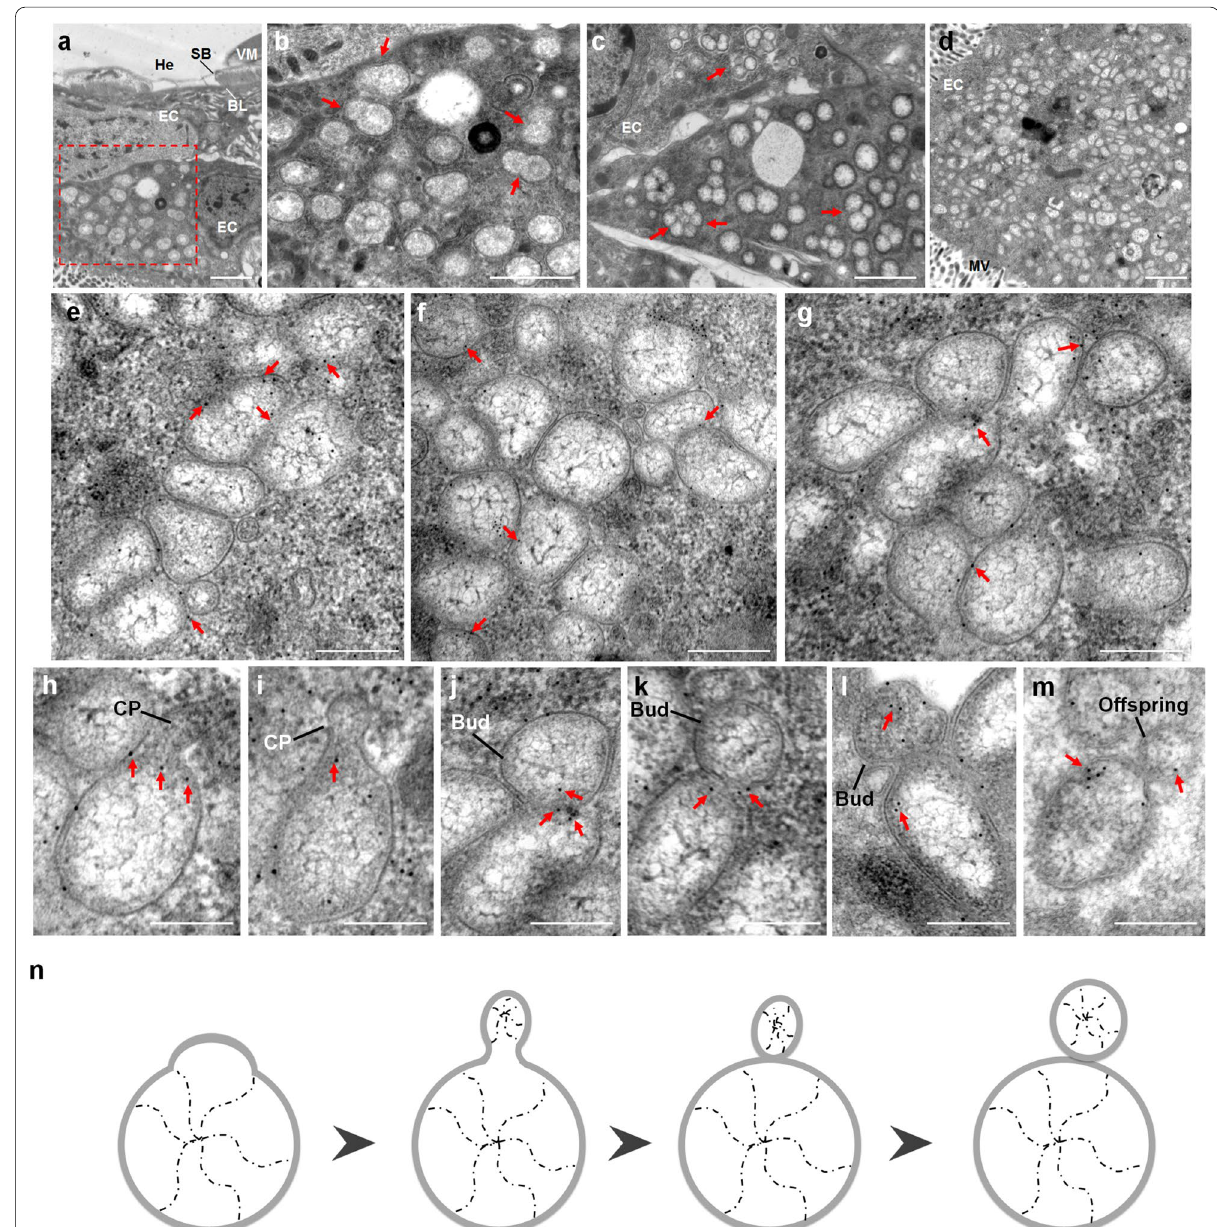
Fig. 6 Electron micrographs showing the multiplication of ROLPs in vector midgut epithelium to produce offspring. a , b One ROLP mother cell was reproducing one daughter cell (arrows). b is the enlarged image of boxed area in a . c More offspring were reproduced to form the grapelike clusters (arrows). d Abundant ROLP offspring were reproduced throughout the epithelial cytoplasm. e – g ROLPs of various sizes reacted with Imp-specific antibody. h – m The process for the budding strategy used by ROLPs to produce offspring. The cellular protrusion of a ROLP cell ( h , i ) was gradually enlarged to initiate the formation of a bud ( j , k ), and then offspring was produced by fission at their junction ( l , m ). n Proposed model of the budding reproduction strategy. ROLP-infected intestines shown in e – m were incubated with Imp-specific antibody and then with 15-nm gold particle-conjugated goat antibody against rabbit IgG as secondary antibody. Arrows indicate gold particles. BL, basal lamina; CP, cellular protrusion; EC, epithelial cell; He, hemocoel; MV, microvilli; SB, serosal barrier; VM, visceral muscle. Scale bars, 500 nm ( a – d ) and 200 nm ( e – m